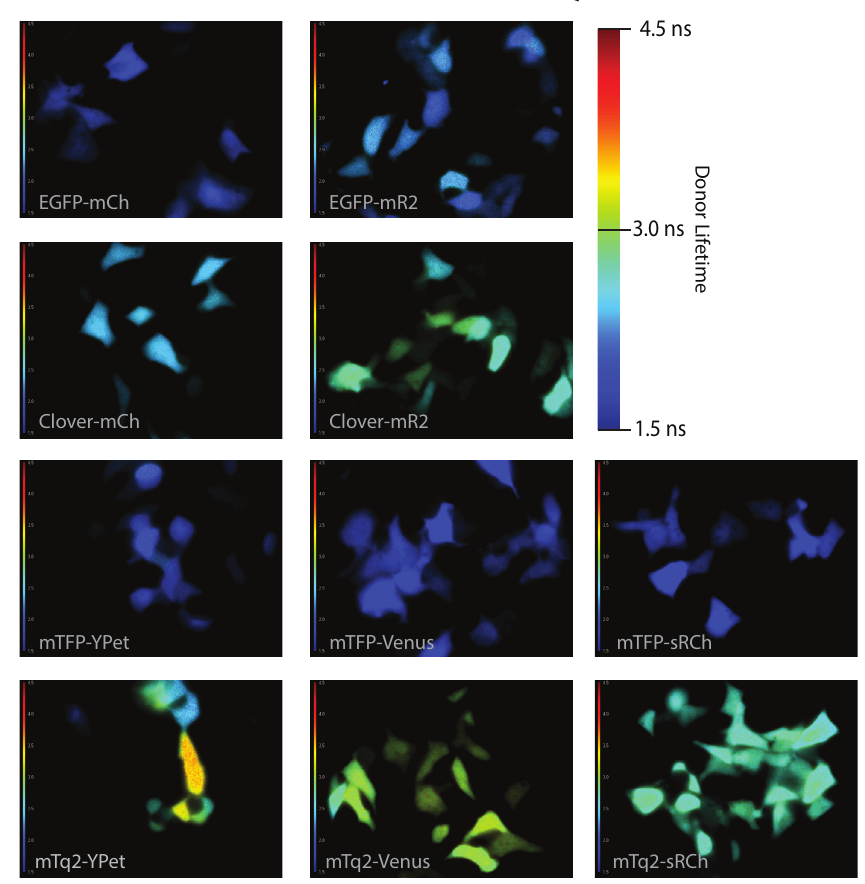
Fig 2. Frequency domain fluorescence lifetime measurements of FRET pairs expressed in mammalian cells. A. Frequency domain measurements of fluorescence lifetimes of FRET donors when fused to acceptors and expressed